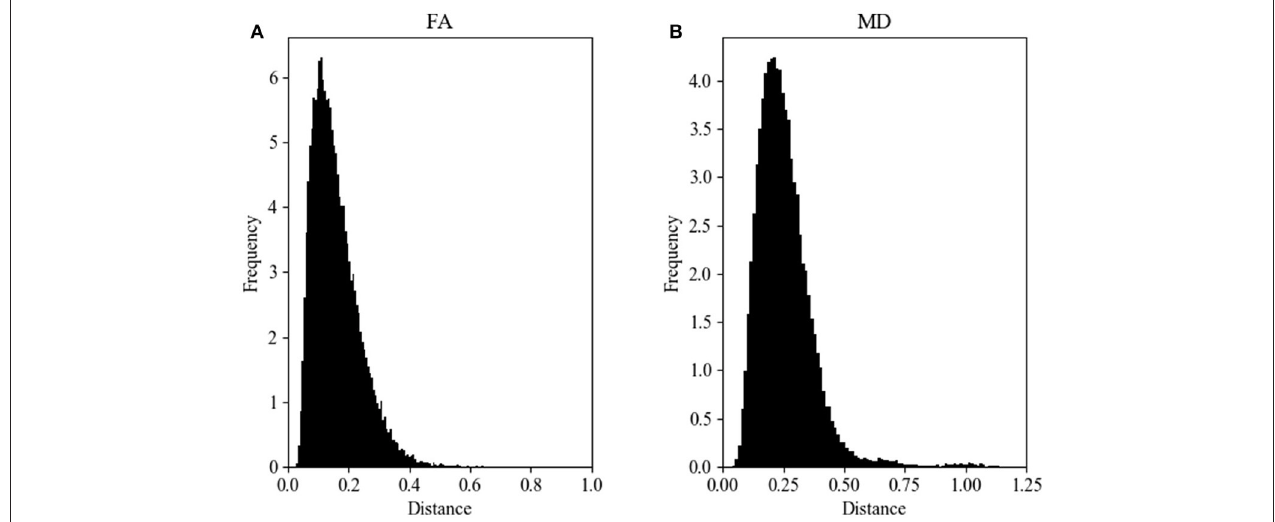
FIGURE 2 | FA (A) and MD (B) map Hellinger histogram distance metric for the within-group Siemens (all b -values, all gradient directions, all field strengths) (number of comparisons = 47,586).